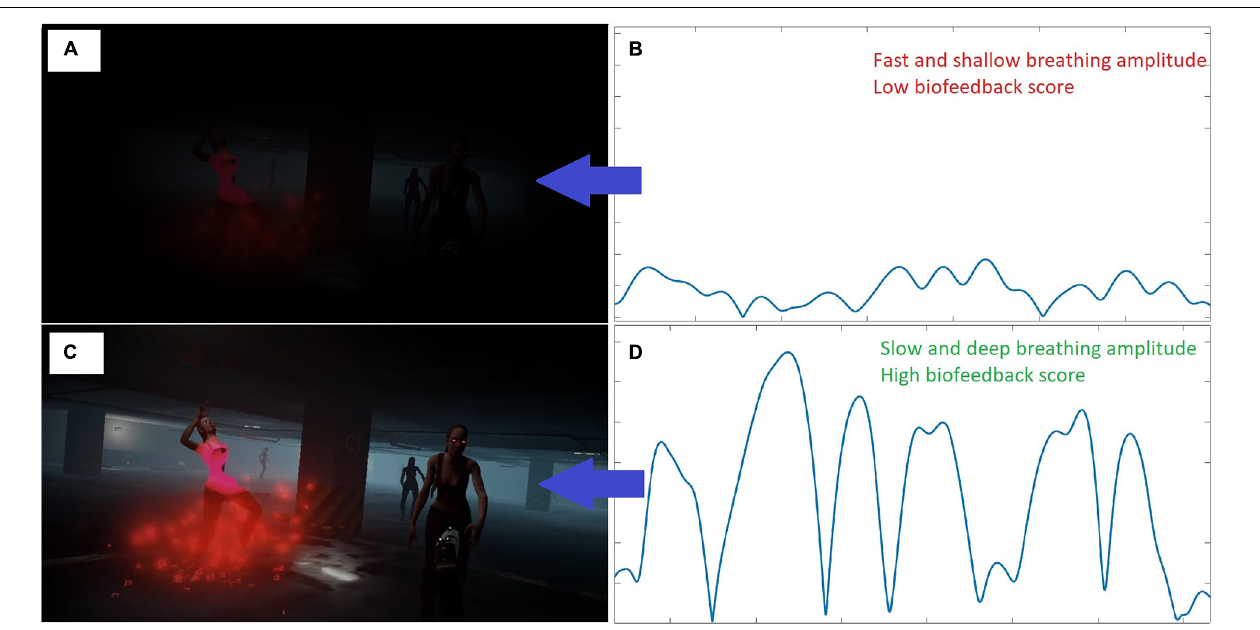
FIGURE 1 | Implementation of the biofeedback as peripheral vision modulation. The quality of the vision (on the left) was linked to the biofeedback score, calculated from the breathing speed and amplitude (on the right); (A) Vision with a biofeedback score equal to 0 (the player is not breathing at the rewarded pace); (B) example of fast and shallow breathing amplitude, corresponding to a breathing biofeedback score of 0; (C) Vision with a biofeedback score equal to 1 (maximum adherence to rewarded breathing pace) or in A-phase sessions in which online biofeedback was not presented to the player; (D) example of slow and deep breathing amplitude, corresponding to a breathing biofeedback score of